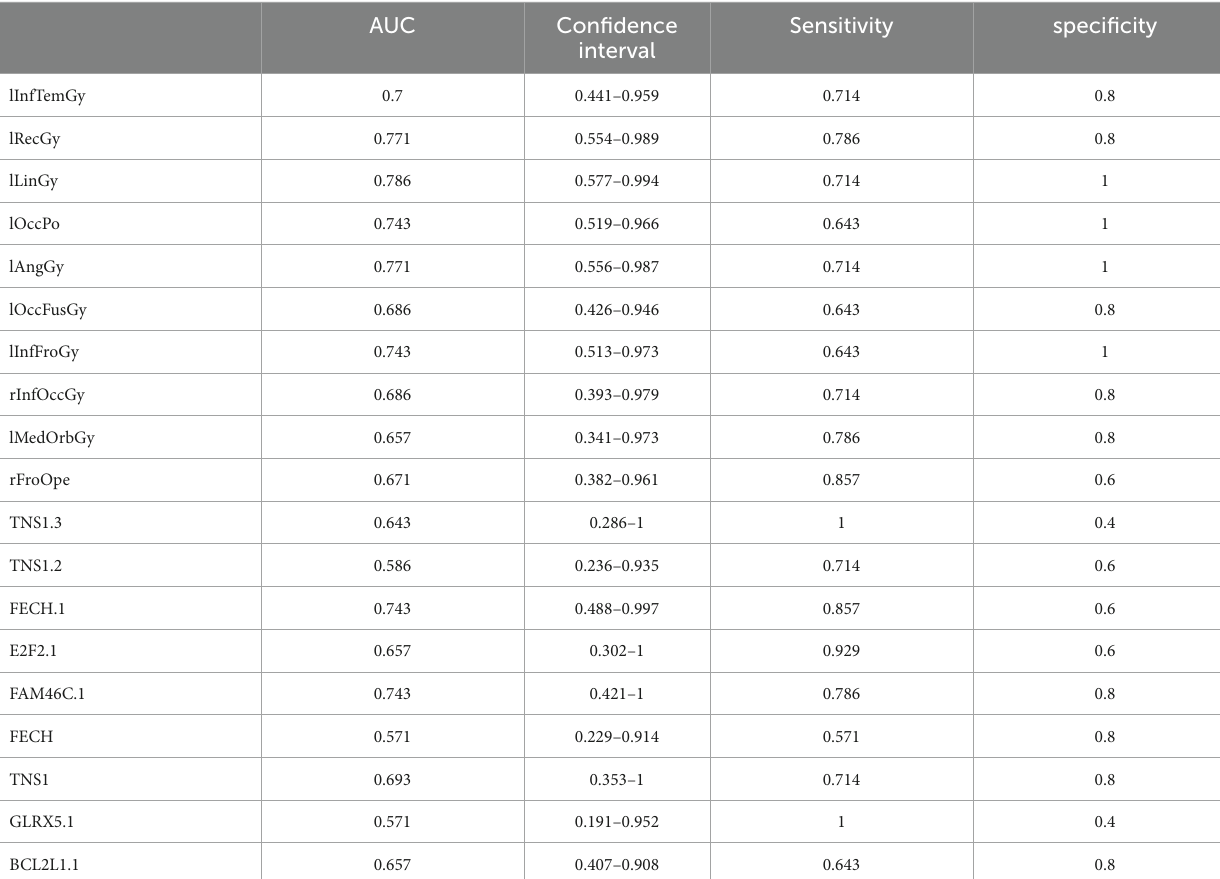
TABLE 8 ROC curve information of a single top features in AD group.